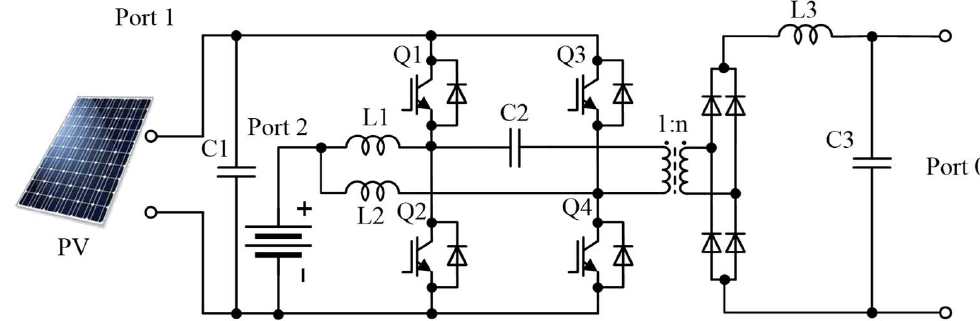
Figure 13. Symmetric Boost Integrated Phase Shift Converter [72].